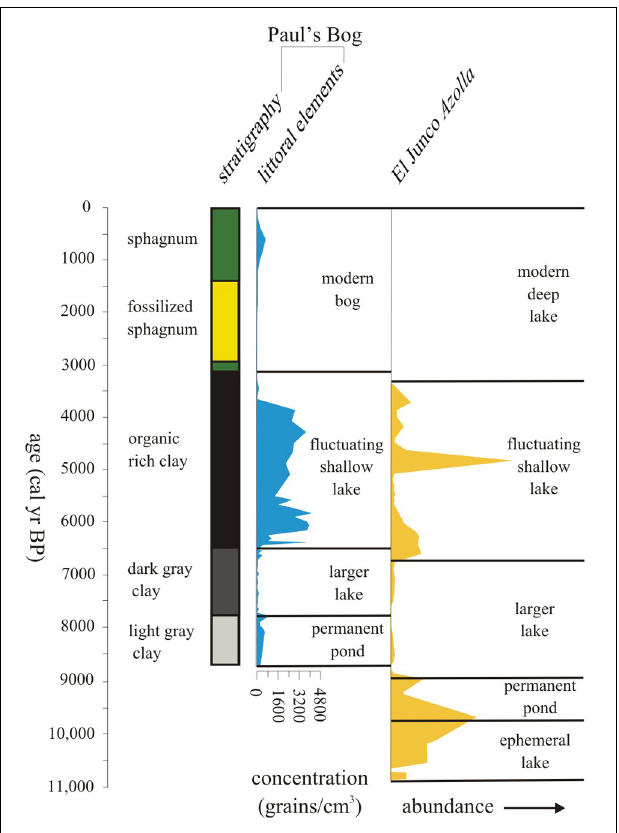
FIGURE 10 | Lake level history of past 11,000 years using littoral pollen elements and core stratigraphy for Paul’s Bog and Azolla abundance for El Junco Crater Lake (from Colinvaux,